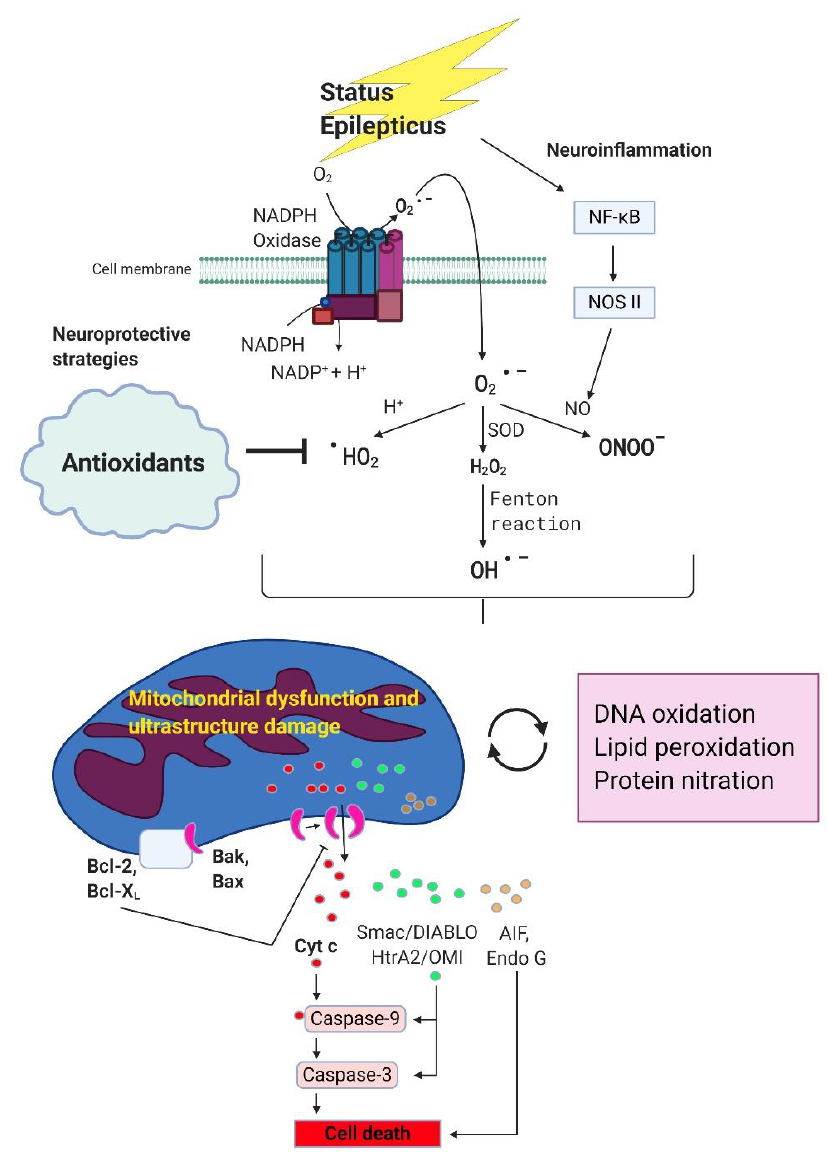
Figure 1. The potential beneficial effects of antioxidants on status epilepticus induced oxidative stress, mitochondrial damage and neurodegeneration. During status epilepticus, superoxide are generated mainly by nicotinamide adenine dinucleotide phosphate (NADPH) oxidase through NMDA receptor